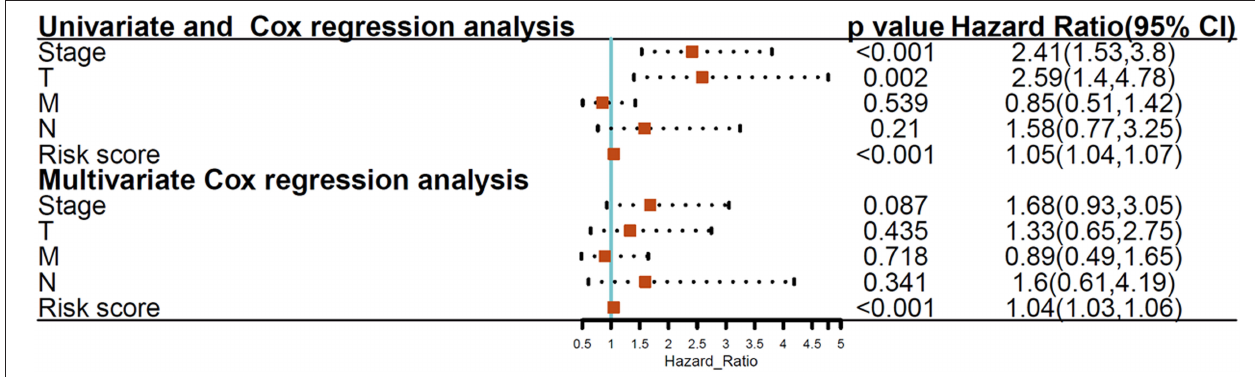
FIGURE 5 | Univariate and multivariate Cox regression analyses between the glycolysis-related gene model and clinical features with overall survival.